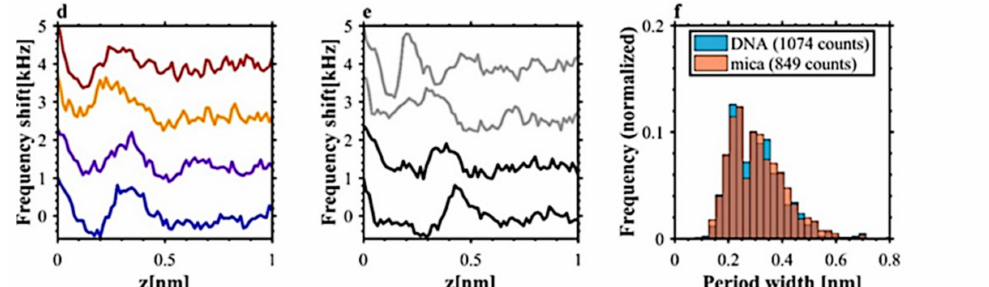
Figure 9. 3D FM-AFM image of the DNA section measured as a set of 50 × 50 frequency shift vs. distance curves. 2D constant frequency shift (300 Hz) representation of the image is presented in ( a ). The color scale reflects the z-height as seen on 3D view in ( b ) panel. The frequency shift cross-section along the red-dot line in ( a , b ) are shown in panel ( c ). The individual frequency shift vs. distance curves taken along the matching color vertical rectangles indicated in ( c ) are plotted in panel ( d ). The curves are shifted vertically to facilitate the comparison. The comparison between frequency shift curves over DNA (marked in black on ( e ) and black diamonds on ( a )) and the curves over mica substrate (marked in gray on ( e ) and gray diamonds on ( a )) clearly show the hydration oscillations with the periods compared on histogram ( f ). Reproduced with permission from Kuchuk, K., Nano Lett. ; published by ACS Publications,